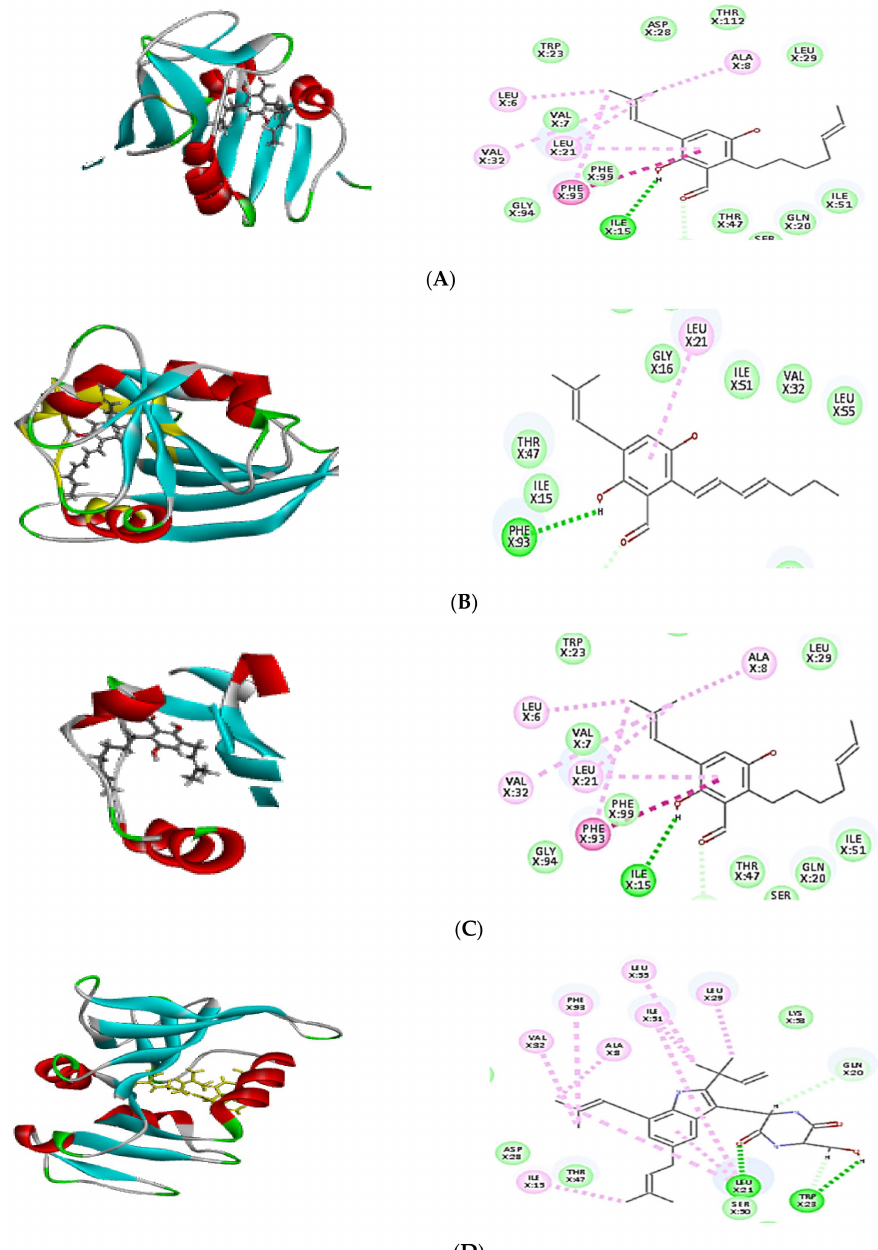
Figure 5. Two-dimensional (2D) and three-dimensional (3D) binding mode of the co-crystalized ligand (Q27) ( A ), dihydroauroglaucin ( B ); isotetrahydroauroglaucin ( C ); cristatumin B ( D ) with dihydrofolate reductase. Residues are labeled with their three-letter amino acid code and their location. Hydrogen-bonding interactions are depicted by a green dashed line between the receptor and the ligand, whereas π –alkyl interactions are represented by a purple dashed